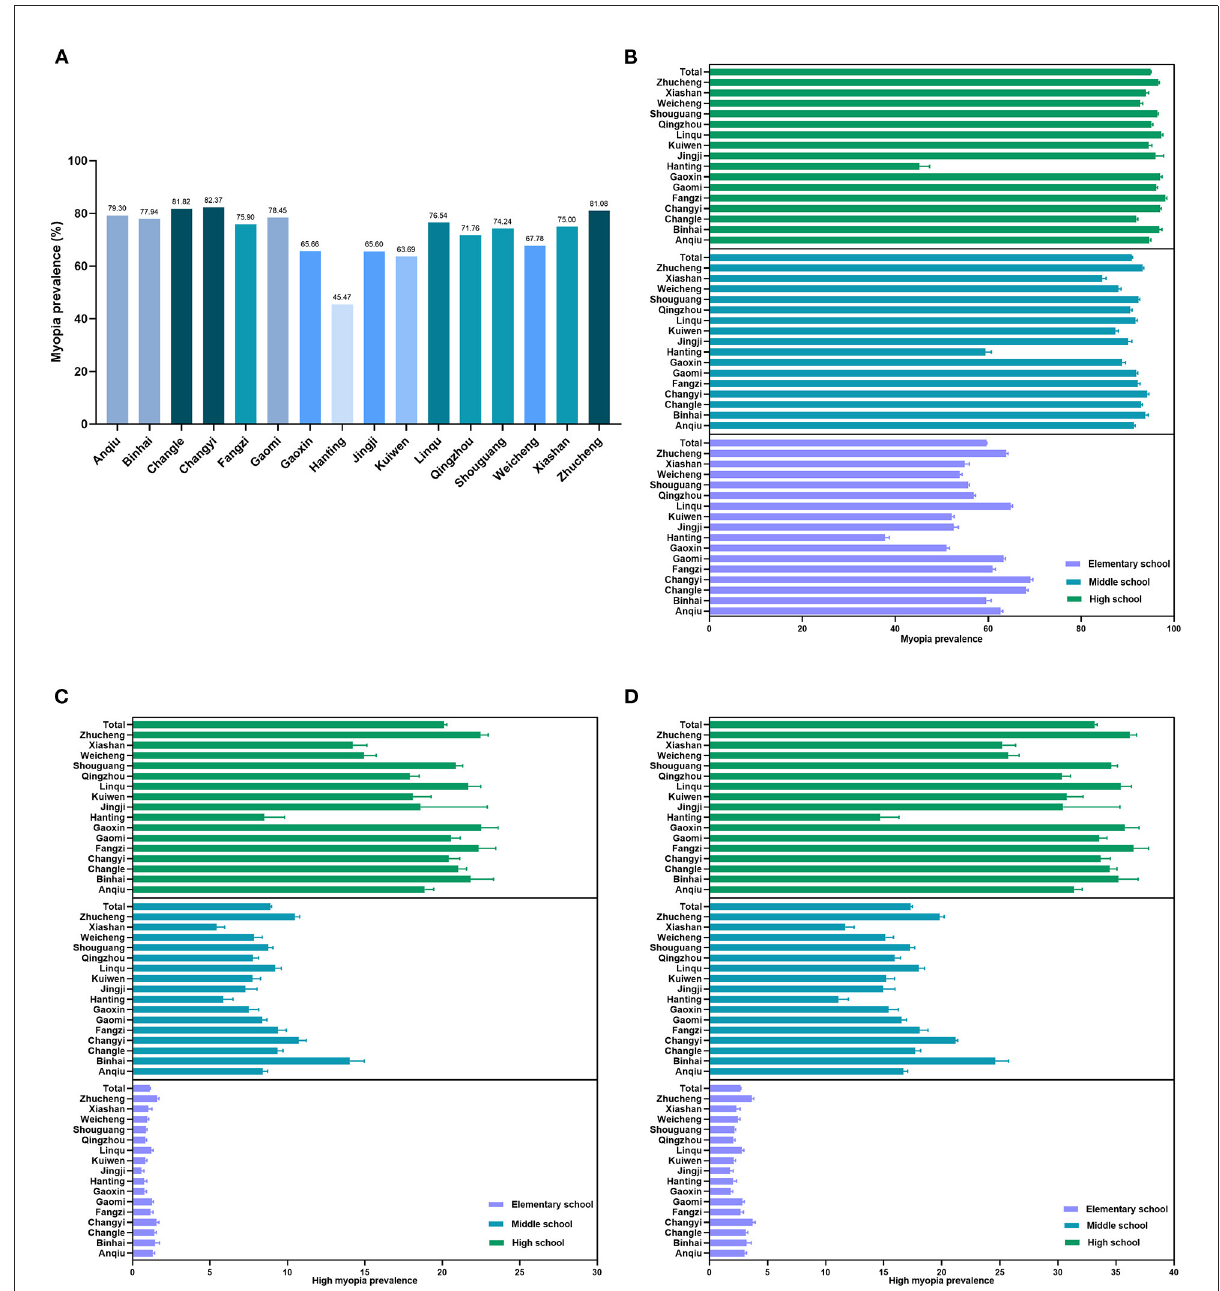
FIGURE1 Myopia and high myopia prevalence of different regions in Weifang. (A) Myopia prevalence in 16 regions. (B) The myopia prevalence of different regions by school levels. (C) High myopia (spherical equivalent, SE ≤ − 6.00 D) prevalence of different regions by school levels. (D) High myopia (SE ≤ − 5.00 D) prevalence of different regions by school levels.